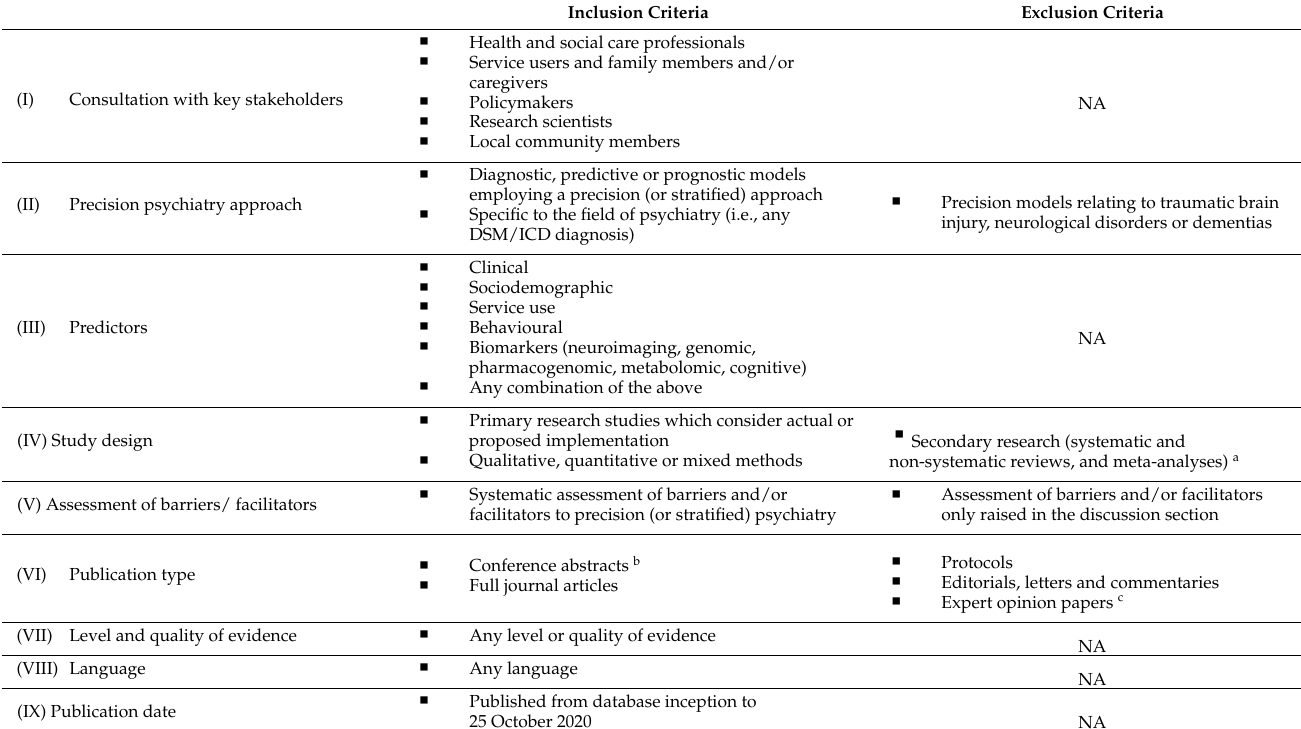
Table 1. Inclusion and exclusion criteria.